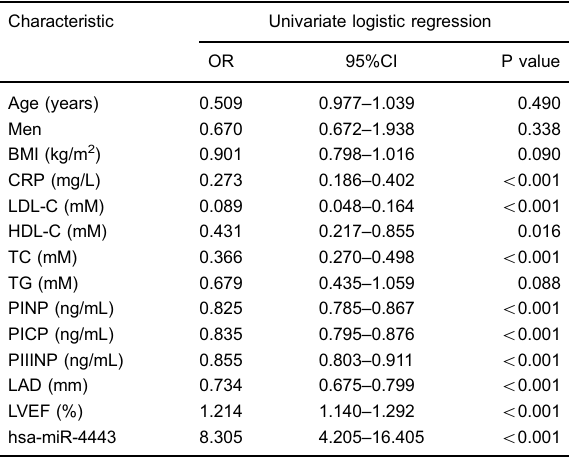
Table 3. Logistic regression analysis of risk factors for atrial fi brillation.